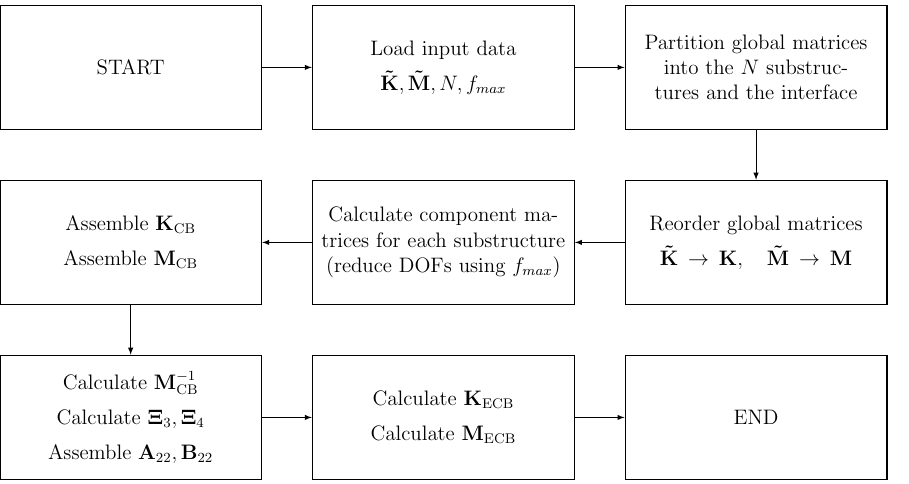
Figure 1. Parallel reduction